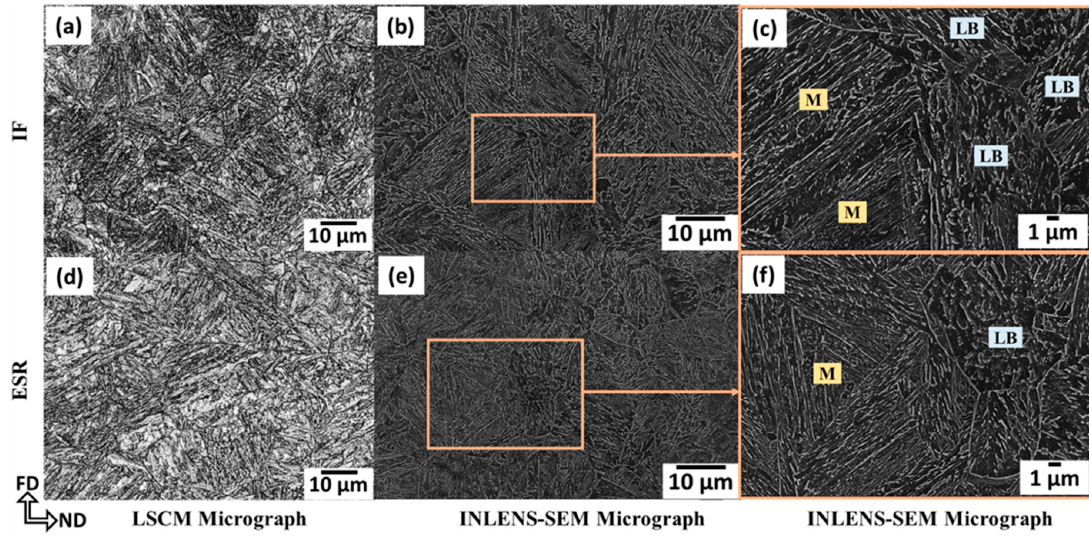
Figure 4. Laser and INLENS-SEM micrograph of UHSS III (IF) without ESR ( a – c ) and with ESR ( d – f ). M: Martensite and LB: Lower bainite.